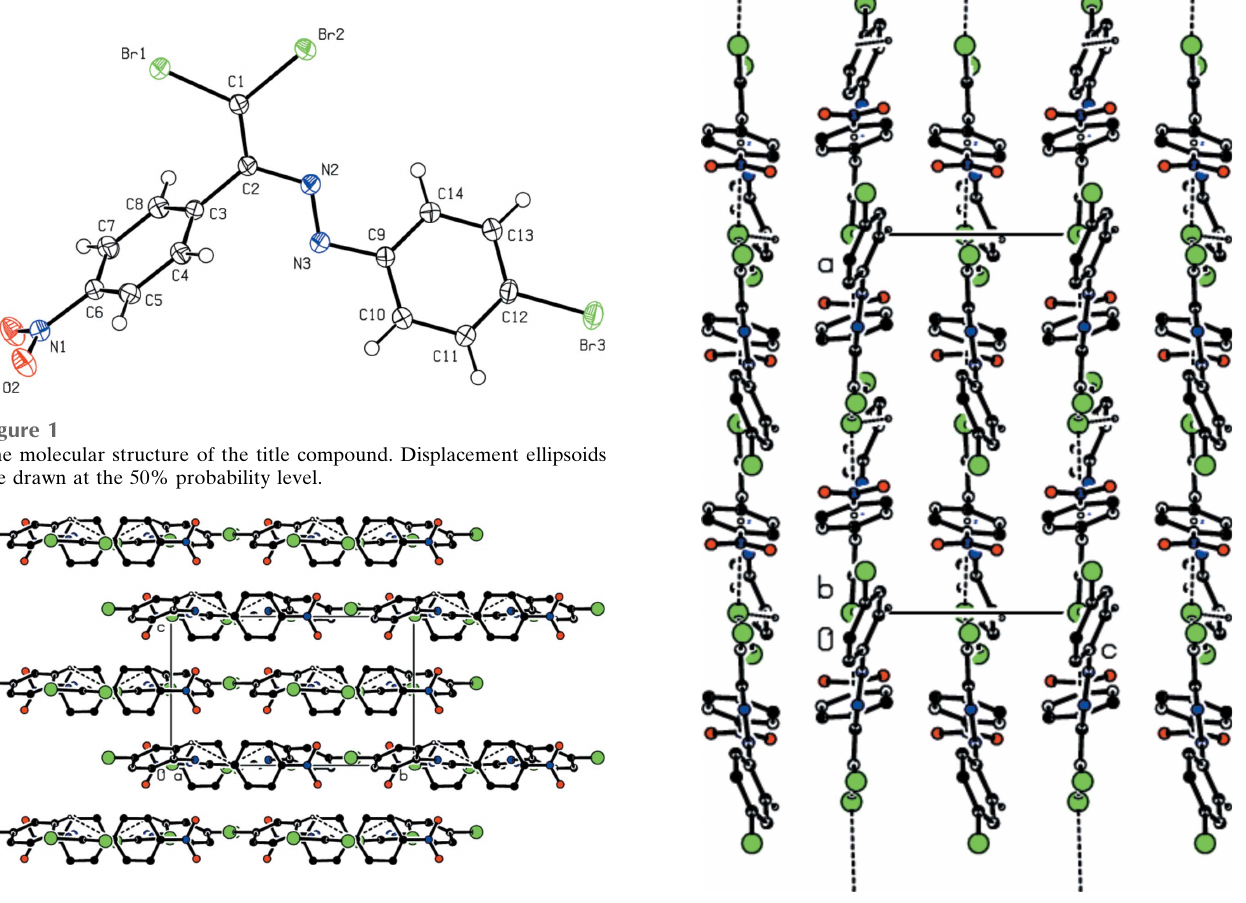
Figure 3 View down the b -axis of the title compound, showing the C—Br (cid:2)(cid:2)(cid:2) (cid:2) interactions.